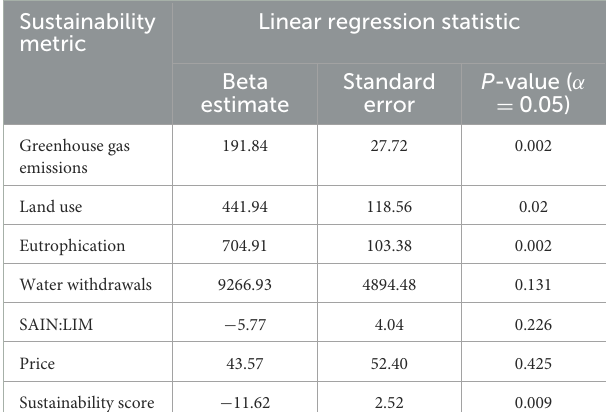
TABLE 5 Statistical results from a series of linear regressions using the proportion of animal derived grams for each diet calculated based on 1 week of meals at 2,000 kcal/day as the independent variable and each of the sustainability metrics and the overall sustainability score used as dependent